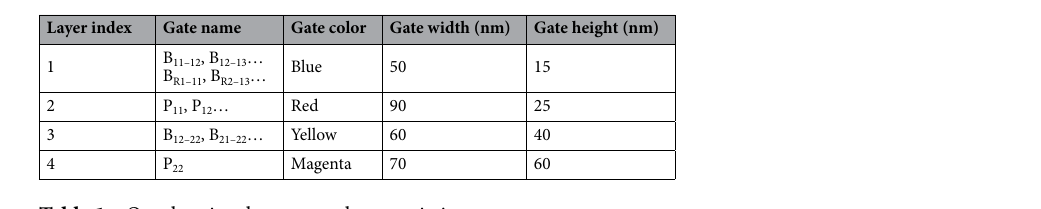
Table 1. Overlapping-layer gate